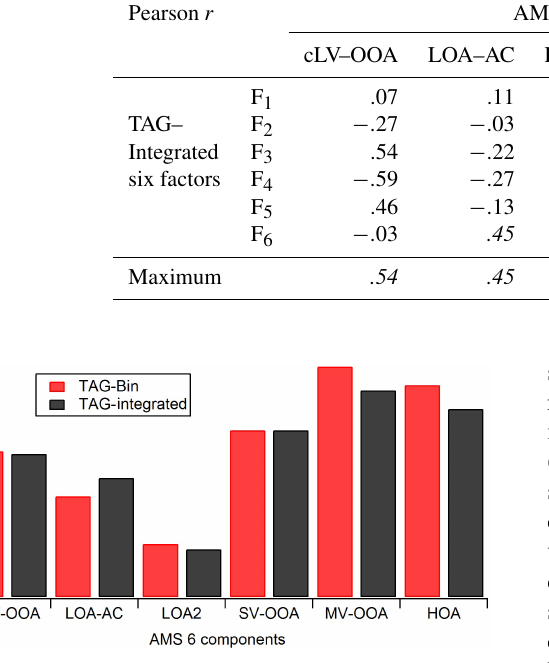
Figure 9. Profiles of the TAG–Integrated six-factor